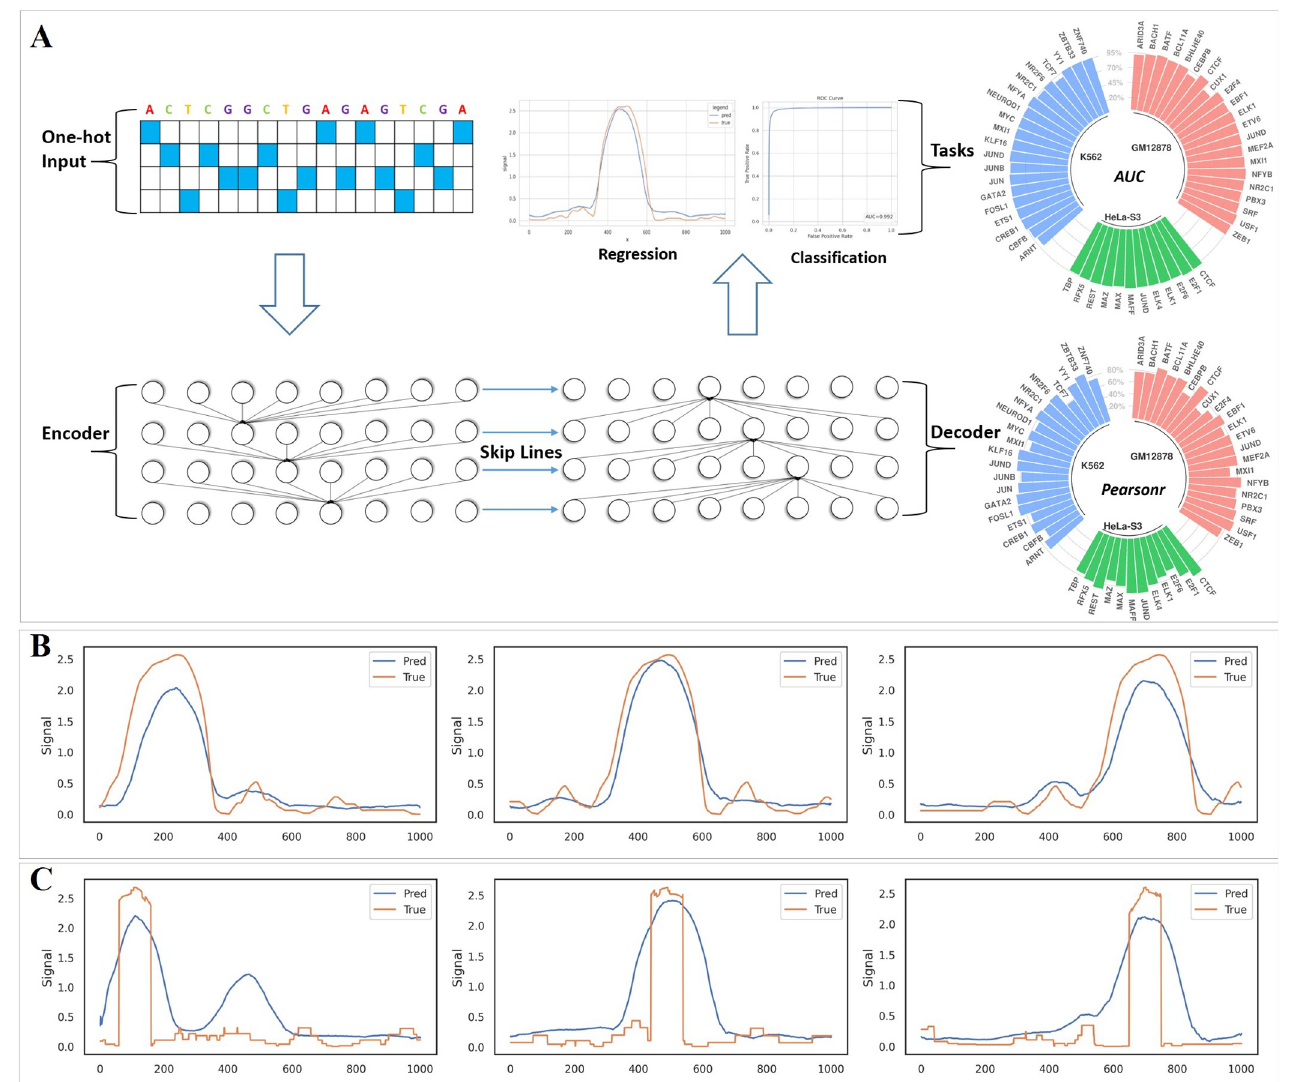
Fig 1. Schematic overview of FCNsignal framework. (A) FCNsignal is mainly composed of an encoder architecture, a decoder architecture, and a skip architecture, which takes as input DNA sequences and predicts the base-resolution signals. FCNsignal can simultaneously realize multiple tasks with high accuracy by using the maximum values of predicted signals. (B) FCNsignal can accurately capture the signals of the shifted binding regions that are separately located at 250bp, 500bp, and 750bp. (C) FCNsignal can accurately capture the signals of the binding regions that were randomly inserted into negative